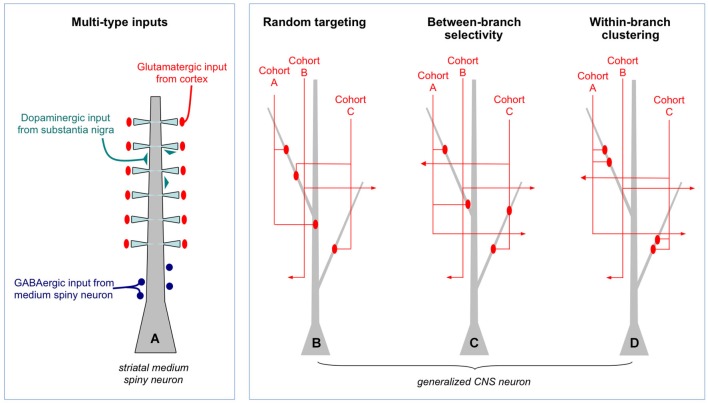
Random and structured patterns of local connectivity. (A) Simplified schematic of the inputs to a medium spiny neuron in the striatum. There is a clear structure to the targeting of different types of inputs. Such multi-type structure is reviewed extensively elsewhere and will not be discussed further. (B) Generalized CNS neuron (e.g., cortical pyramidal cell) in which inputs of one type only are shown. Within that type, different input cohorts are defined solely on the basis of their activation histories: each cohort (A or B, among many) has correlated activity whereas different cohorts are uncorrelated. In this example, synapses from three input cohorts are distributed randomly throughout the dendritic field. This is a Braitenberg network. (C) Example of between-branch selectivity. Three cohorts have equal access to the leftmost dendrite but only one actually synapses with it. (D) Example of within-branch structure. Synapses from each cohort are spatially clustered.